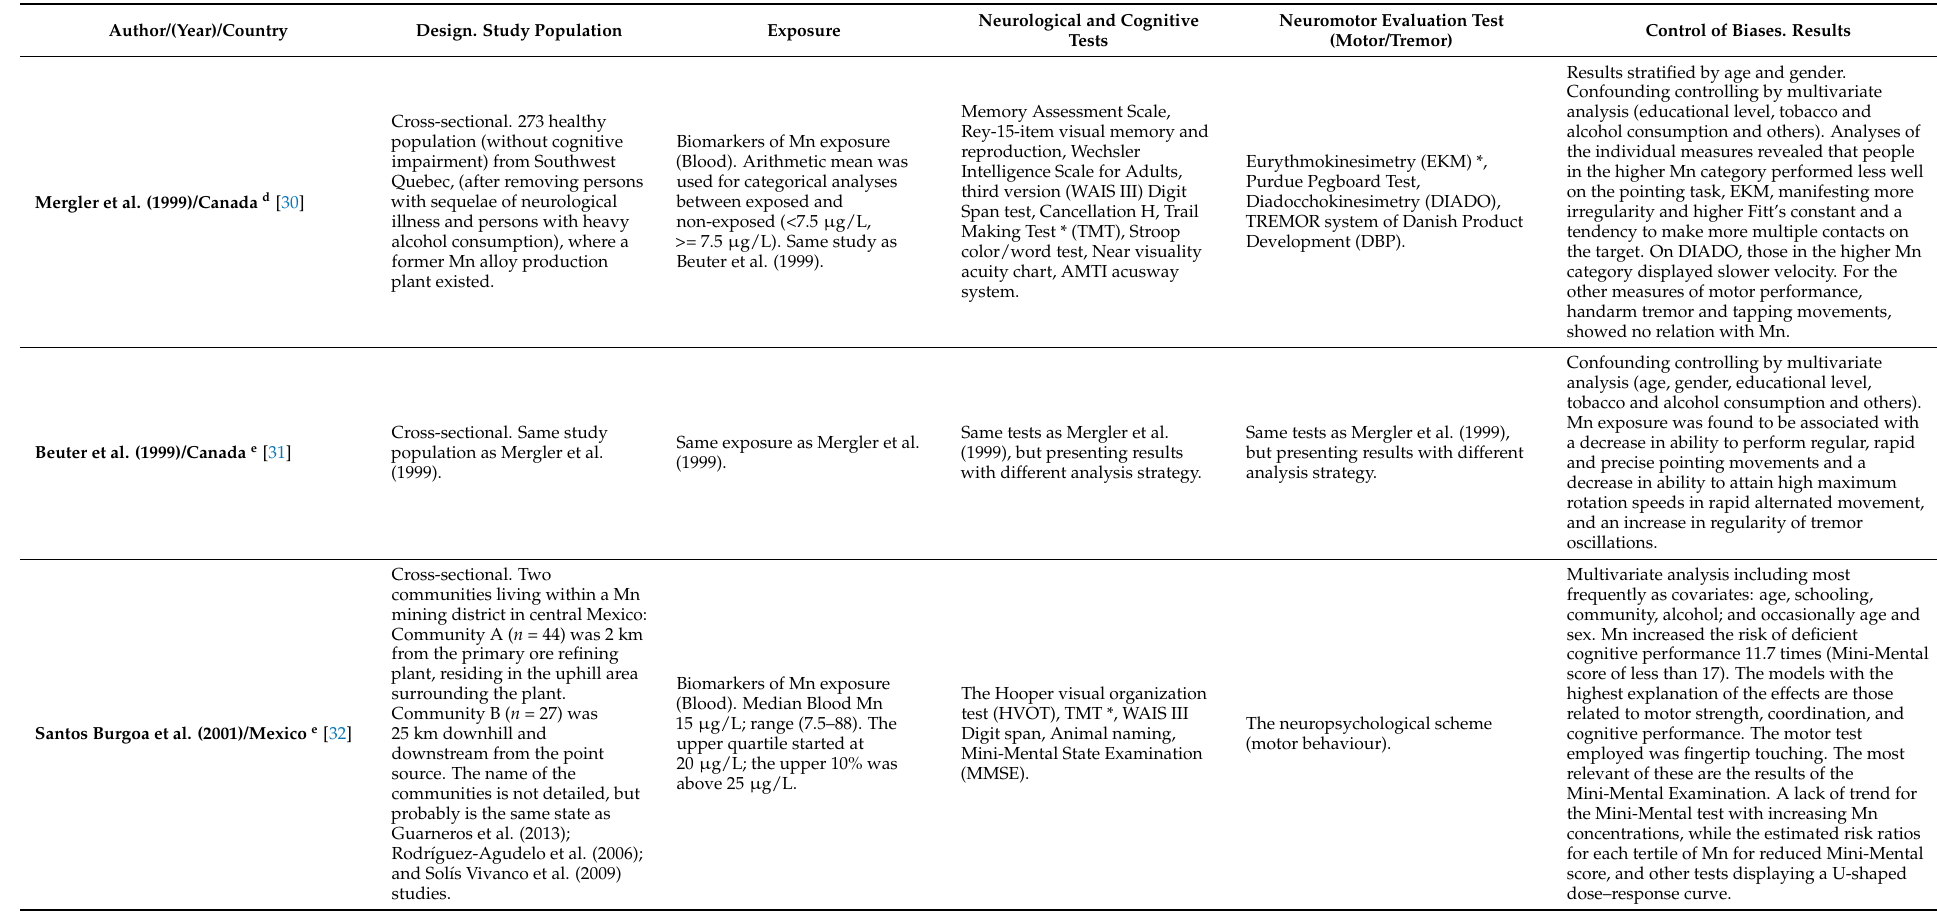
Table 2. Characteristics of studies included in the systematic review by chronological order of